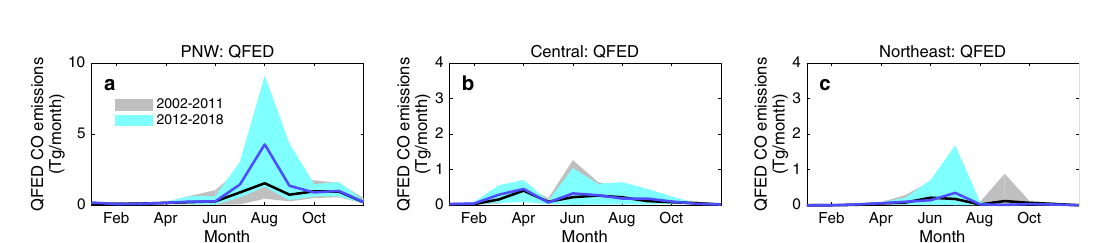
Fig. 4 Seasonal patterns of wild fi re carbon monoxide (CO) emissions. Mean seasonal cycles for wild fi re CO emissions in terragrams (Tg) in each region, a PNW, b Central USA and c Northeast, for each time period using the Quick Fire Emissions Dataset (QFED) inventory. Black lines follow the averaged monthly mean for 2002 – 2011, blue lines for 2012 – 2018. Shading represents the range in inter-annual variability for each